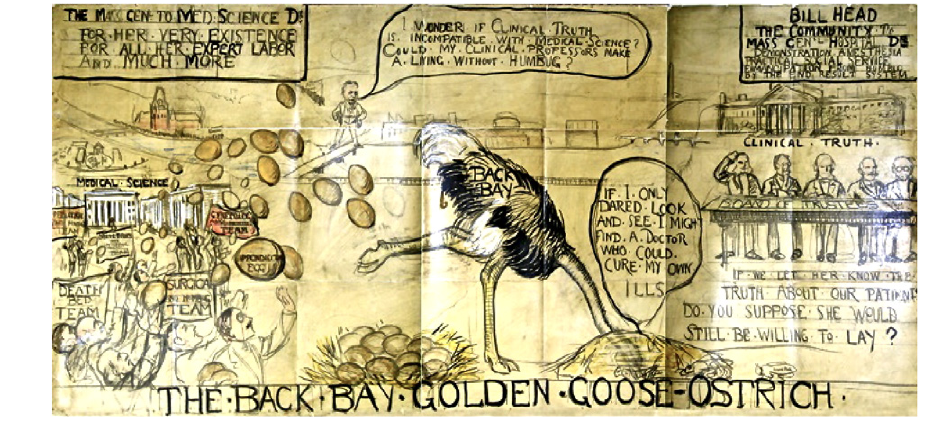
Figure. 2 Codman cartoon from 1915. Reproduced from http://www.massgeneral.org/News/assets/images/